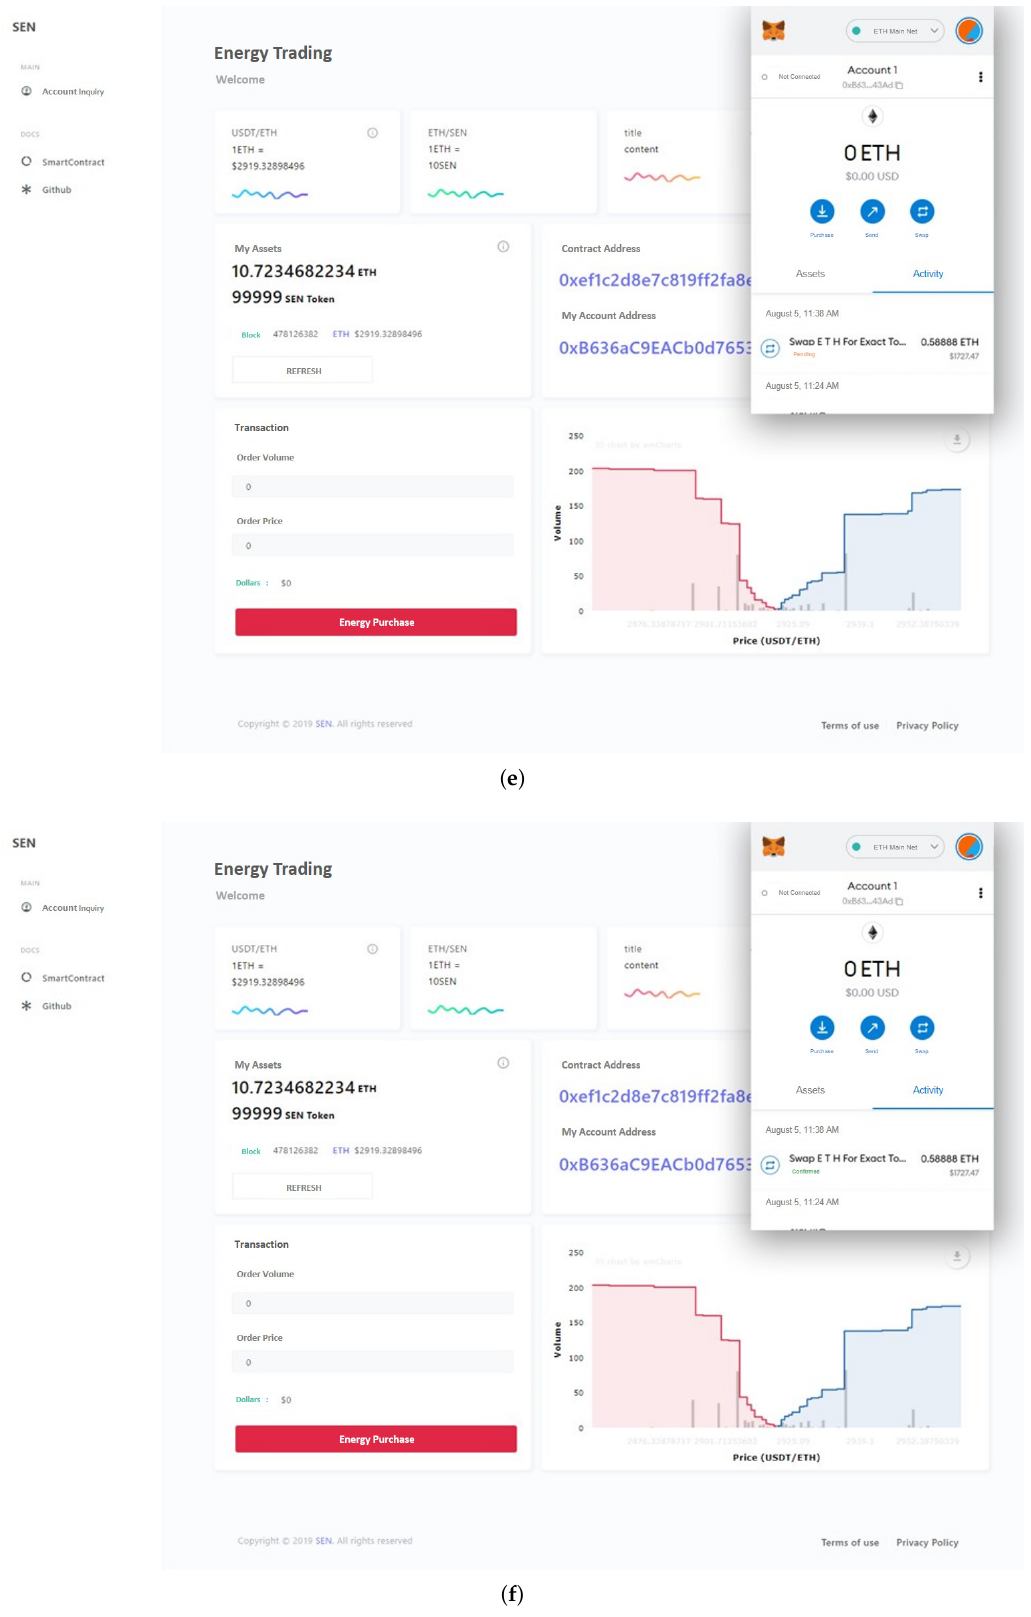
Figure 7. Process of energy trading in web page. ( a ) Real time user’s information; ( b ) Purchase section; ( c ) Purchase progress pop-up window; ( d ) Ethereum transaction preview; ( e ) Transaction in progress; ( f ) Transaction